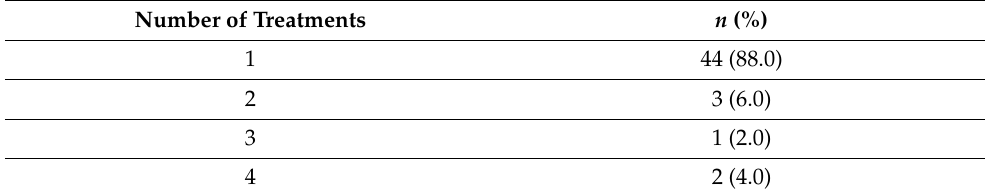
Table 3. Number of treatments for the population.